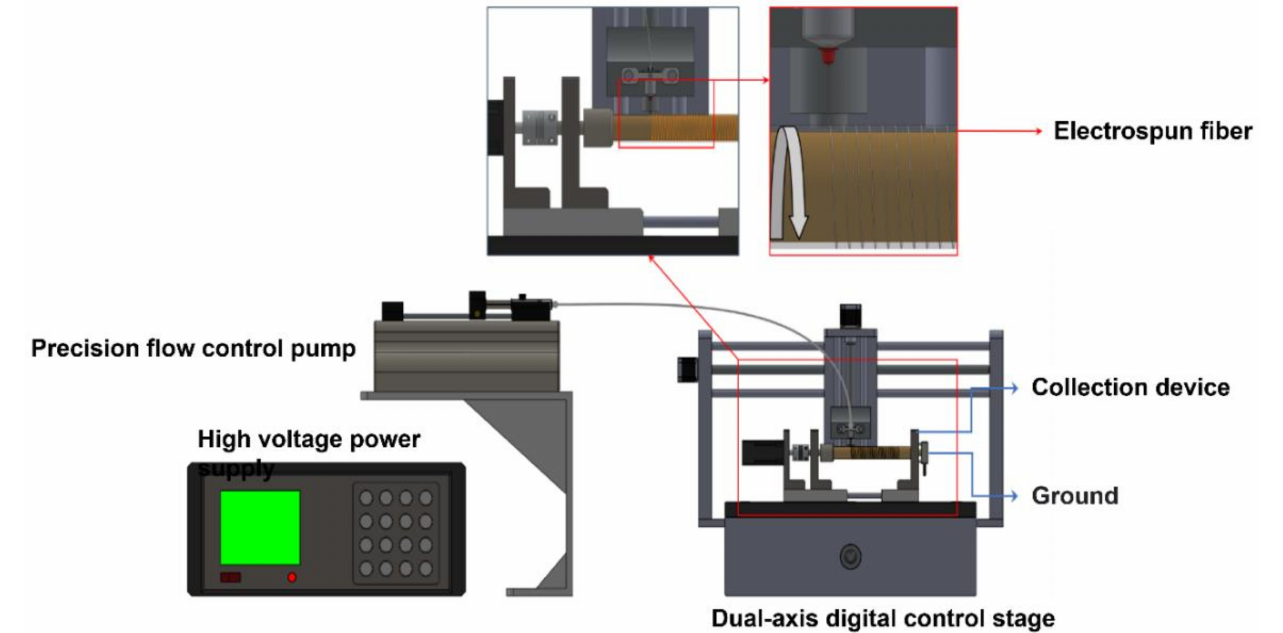
Figure 2. Schematic diagram of near-field electrostatic spinning